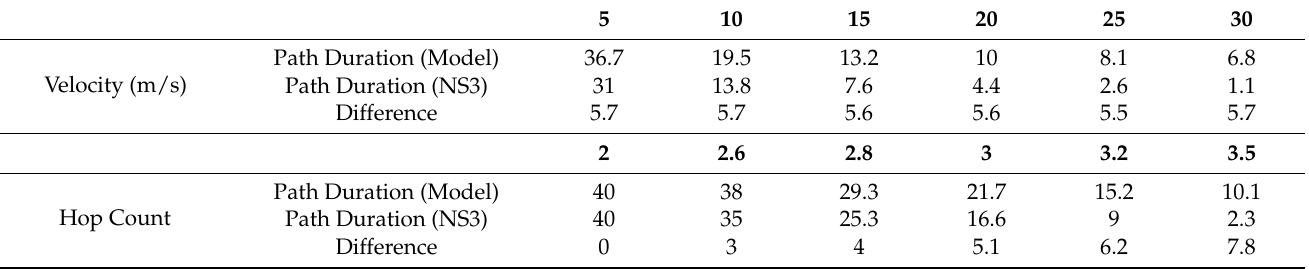
Figure 12. Relationship between the DSDV path duration and increasing the number of hops.